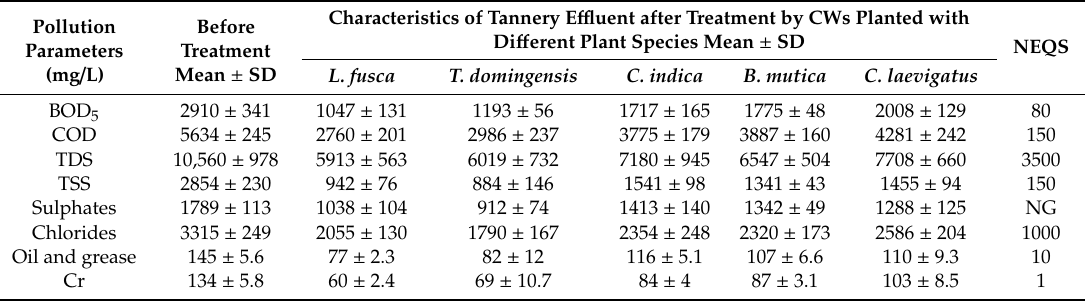
Table 2. Pollutant reduction in tannery effluent by CW phytotechnology and its comparison with NEQS. Pollution Parameters